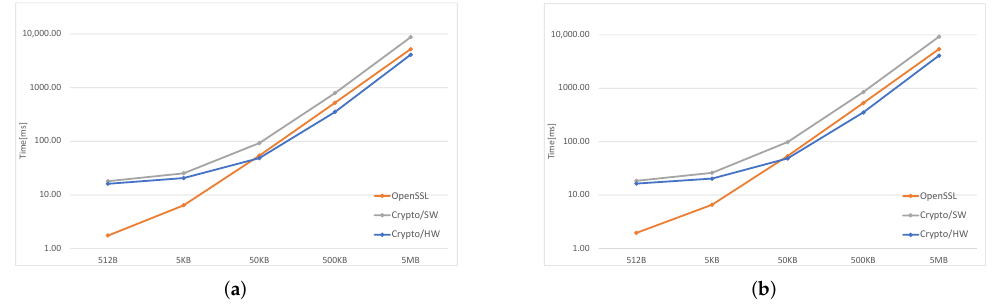
Figure 5. Time required to compute AES modes on increasing file sizes. ( a ) AES-ECB. ( b ) AES-CBC. Figures 3–5, which cover all SHA algorithms and two AES modes, ECB and CBC, clearly show that, for files smaller than 50 KB both Crypto/HW and Crypyo/SW show the same performance, which is much worse than plain OpenSSL; for large files, the fastest option is Crypto/HW, while Crypto/SW remains slower than OpenSSL in most